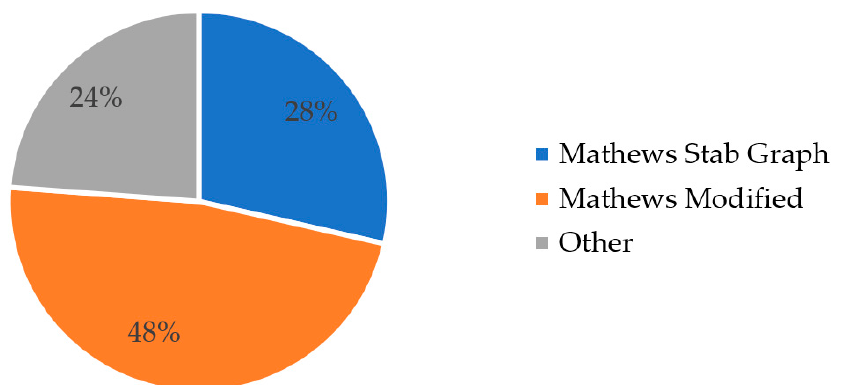
Figure 6. Ratio of the applied empirical method for designing stopes: Mathew’s stability graph, Mathews modified stability graph, and other (e.g., rock mass rating, RMR).